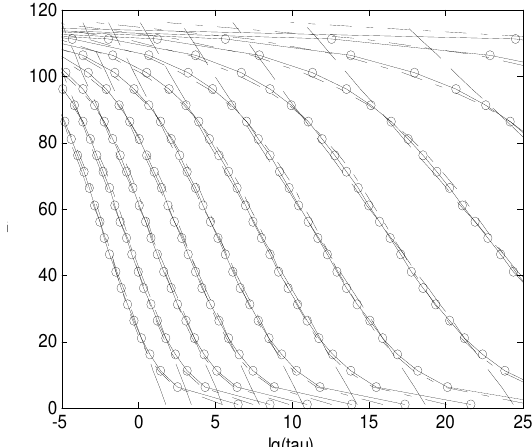
Fig. 1. Types of long-term durability curves of alloy